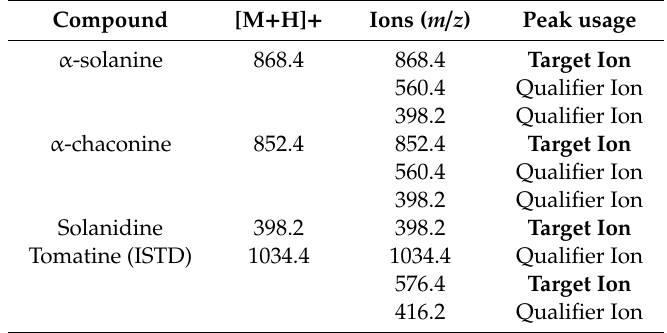
Table 2. Validation of linearity, limit of detection (LOD), limit of quantification (LOQ), and recovery for individual Table 1. Ions used in single ion monitoring for quantification of glycoalkaloids (GAs) by LC- ESI/MS.